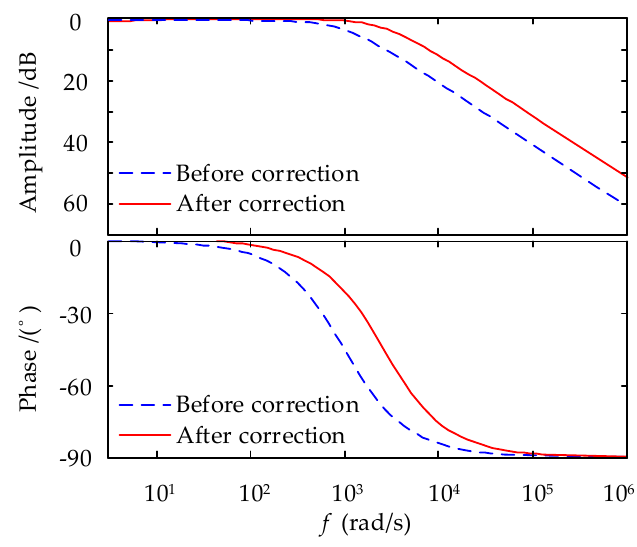
Figure 10. Bode plots characteristic of the controlled object before and after correction.